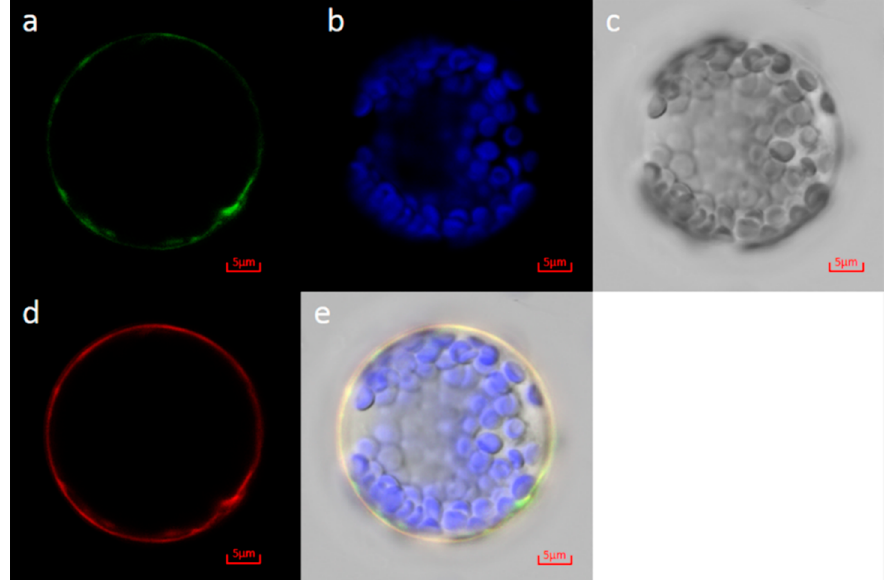
Figure 8. Subcellular localization of the MD15G1108400-GFP fusion protein in Arabidopsis mesophyll protoplast. From a to e : ( a ) MD15G1108400-GFP fusion protein fluorescence, ( b ) chlorophyll auto-fluorescence, ( c ) optical photomicrographs (bright field), ( d ) pm-rk (plasma membrane marker: CD3-1007) protein fluorescence, and ( e ) overlay of bright and fluorescence illumination.